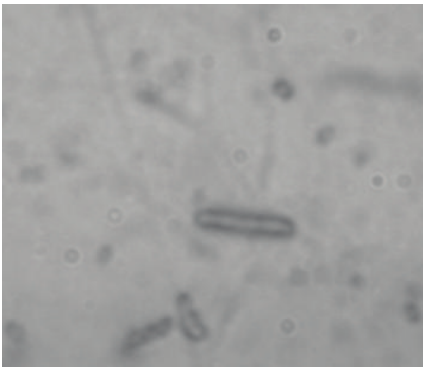
Figure 1: Sporosarcina aquimarina